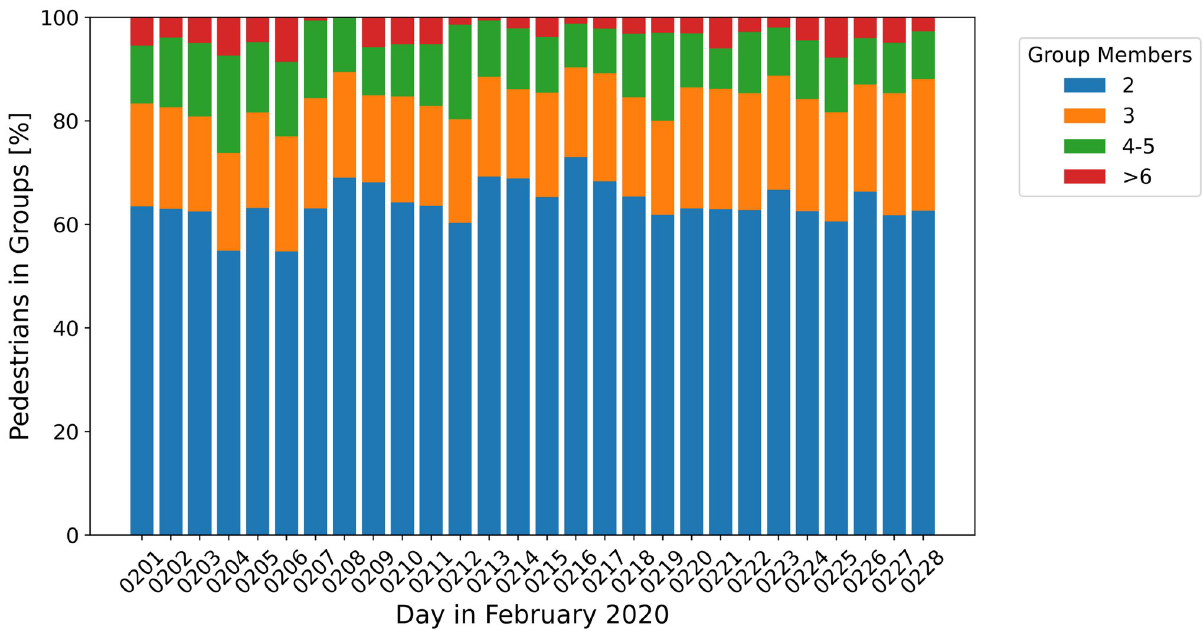
Fig 4. Distribution of group sizes as percentage of the number of passengers assigned to social groups. Each group size is less frequent than the next smaller group size.